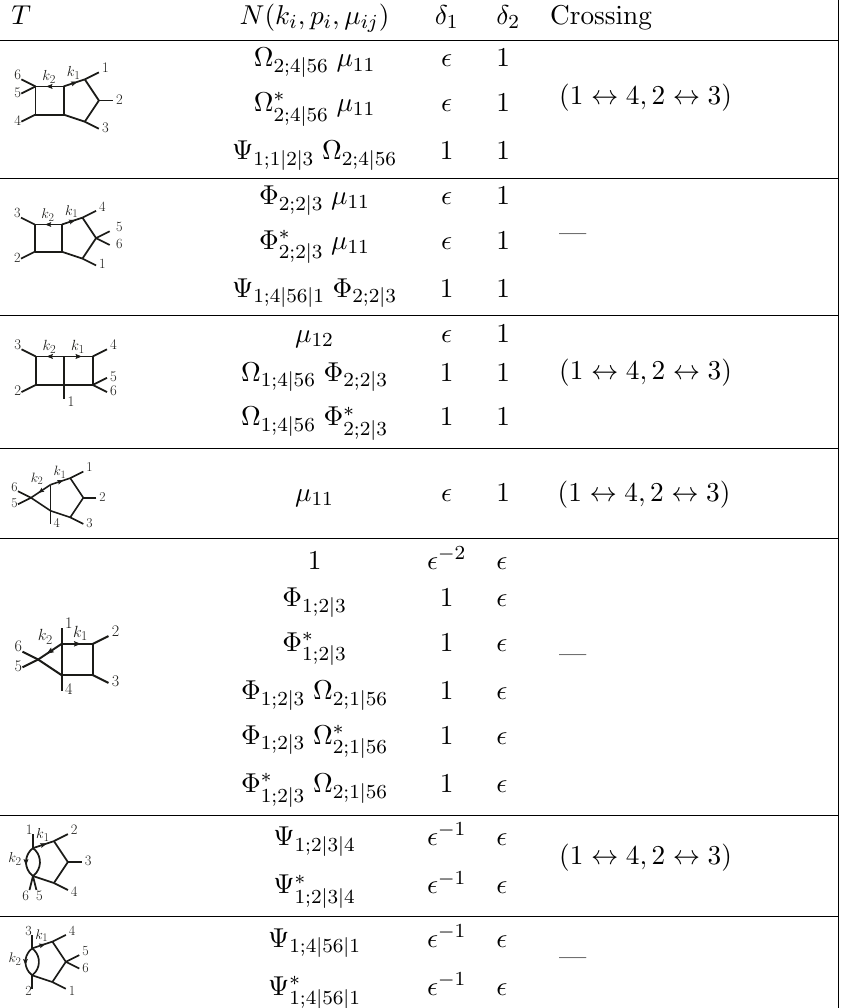
Table 1 . Master integral topologies made up of (cid:12)ve external legs with local numerator insertions. The topology T and numerator N ( k i ; p i ; (cid:22) ij ) correspond to the integral de(cid:12)nition in eq. (4.3). Numerator building blocks (cid:9), (cid:8) and (cid:10) are de(cid:12)ned in eq. (4.6). (cid:14) 1 is the order at which the expansion of the master integral starts, while (cid:14) 2 the highest order in (cid:15) needed from the master integral for the amplitude